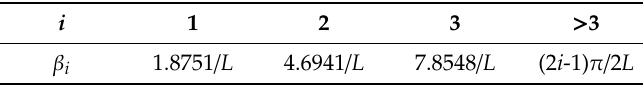
Table 1. Parameterized representation of the solution.